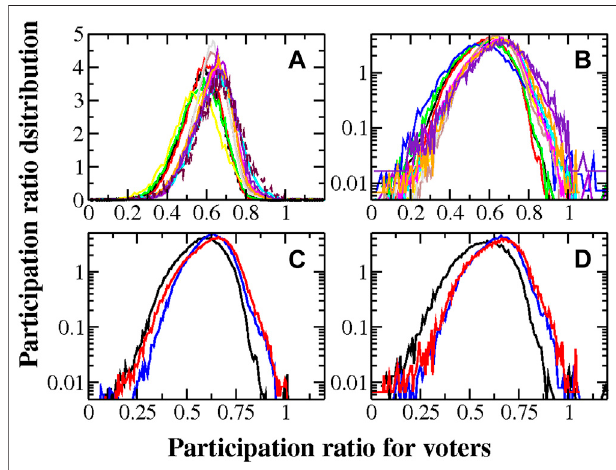
FIGURE 5 | Distributions of the participation ratio of voters, τ , for the presidential elections are plotted. In (A) , all the cases are presented, consideringall thevalidvotersand regularcabinsand theratioofthezones ( I ) to ( II ) for the elections considered. In order to notice the lack of Gaussianity, the same graph is plotted in a semilog scale in (B) . In (C,D) , the distribution for zones ( I ) and ( II ) for the 2006 (in black), 2012 (in blue), and 2018 (in red) elections is